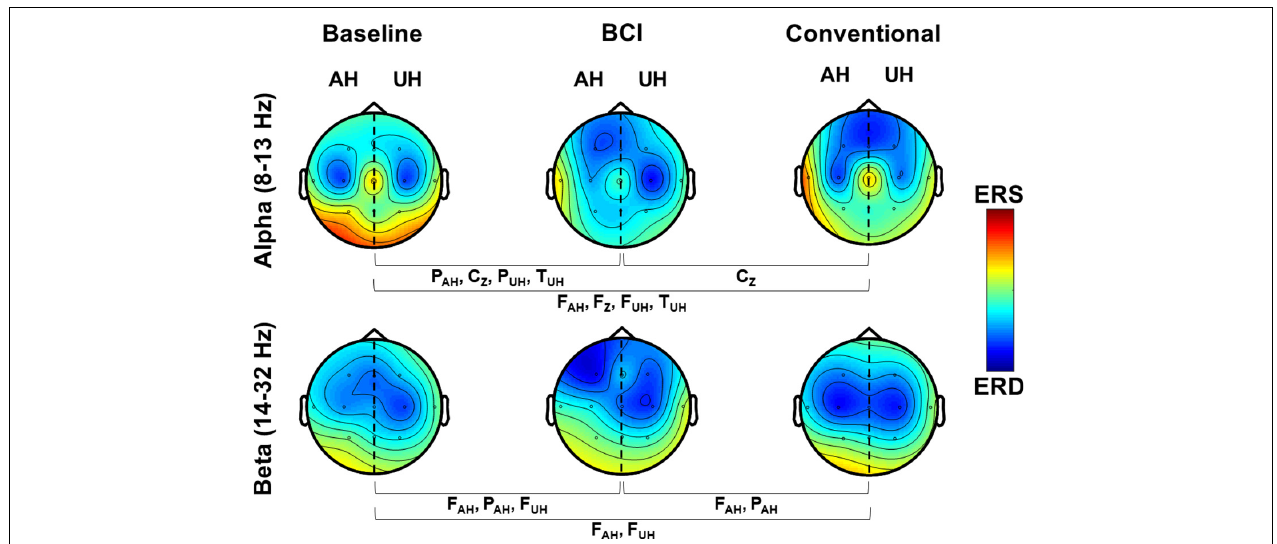
FIGURE 6 | Grand average ERD/ERS maps in alpha and beta. ERD/ERS is shown over affected and unaffected hemispheres during MI (4–7 s). Channels that presented significant differences ( p < 0.017) between measurements are